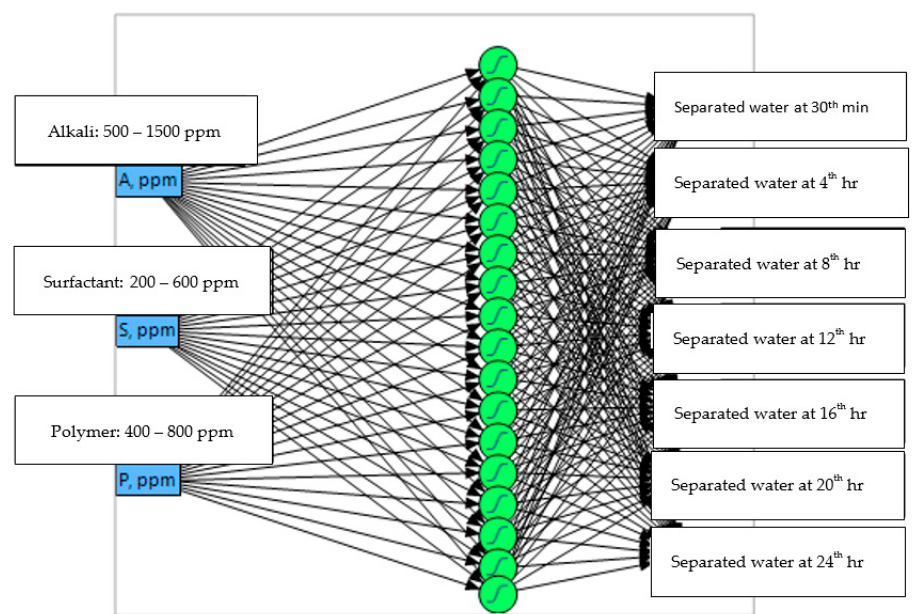
Figure 6. Topology of the boosted ANN.